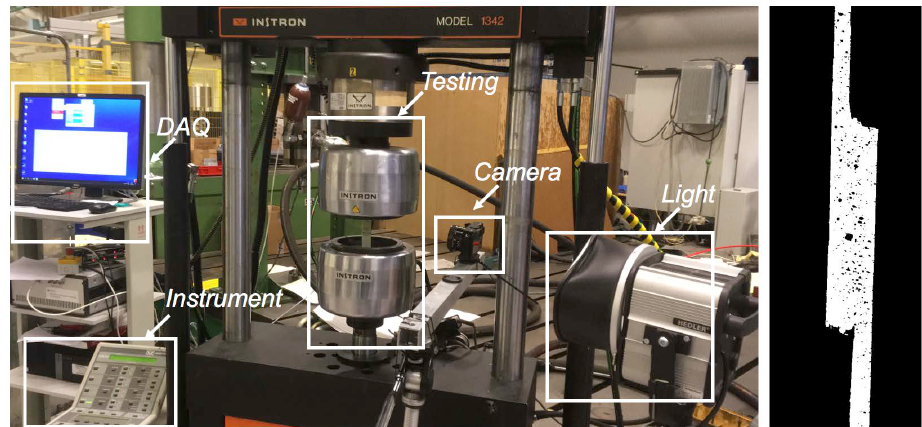
Figure 8. Setup for testing adhesive joints under lap shear ( left ) and through the thickness surface prepared for failure analysis ( right ).